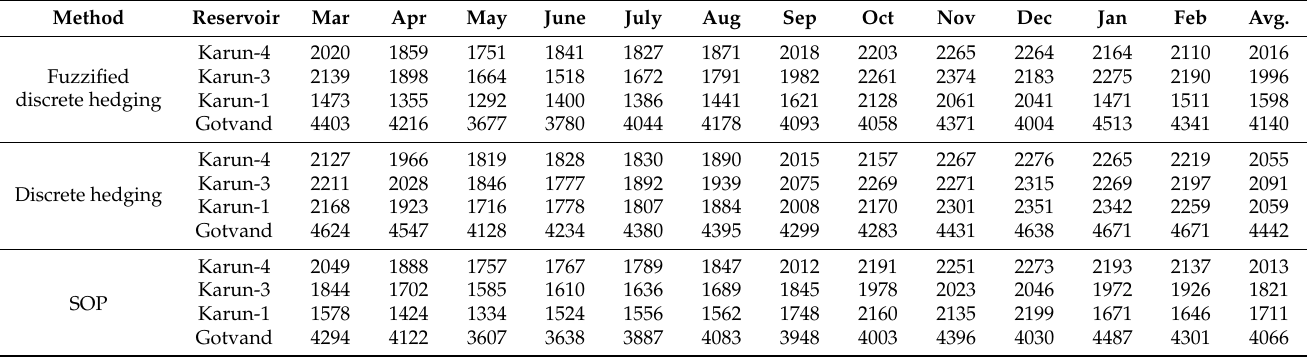
Table 7. Average storages during the test period